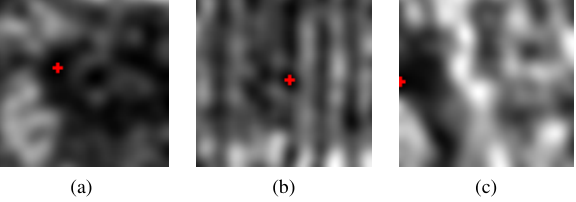
Figure 5. Costmap for the vertex optimisation. The chosen vertices are represented by a red